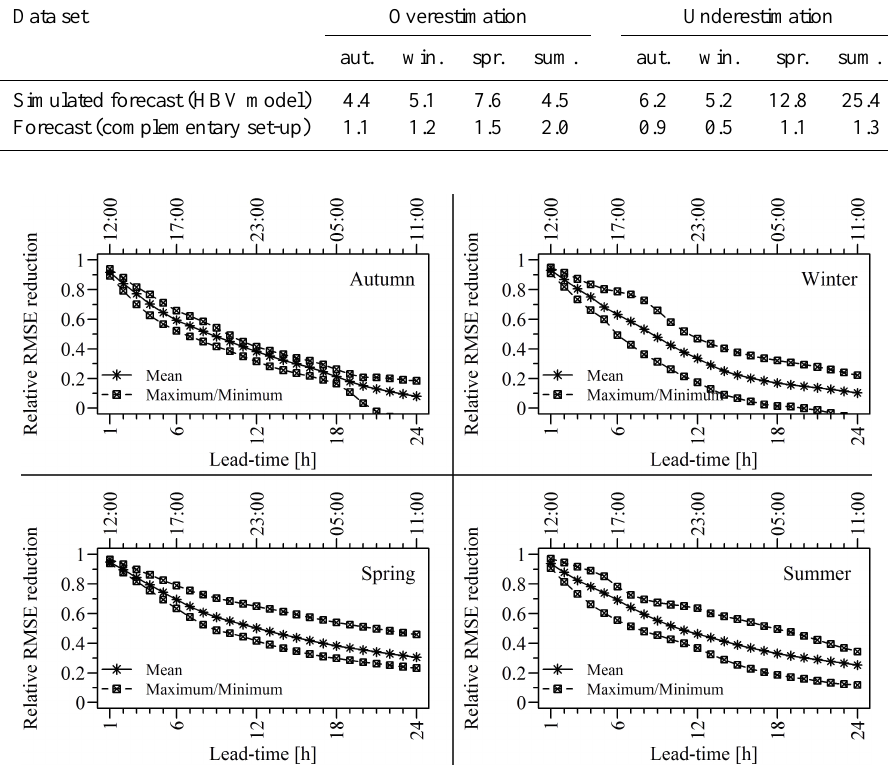
Table 3. Ratio between occurrence frequency of low PVE ( ≤ 10%) and high PVE ( > 10%) errors for the hydrologic years 2006–2010.